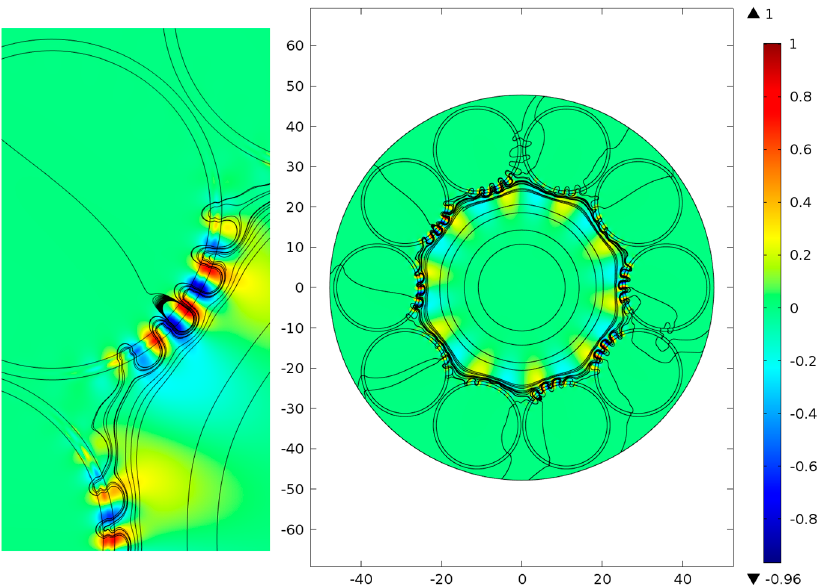
Figure 5. Distribution of the transverse Poynting vector component projection on the radius vector direction in the cross section of a silica glass negative curvature hollow core fiber (NCHCF) with ten very closely located cladding capillaries. The streamlines for the transverse component of Poynting vector (black lines).